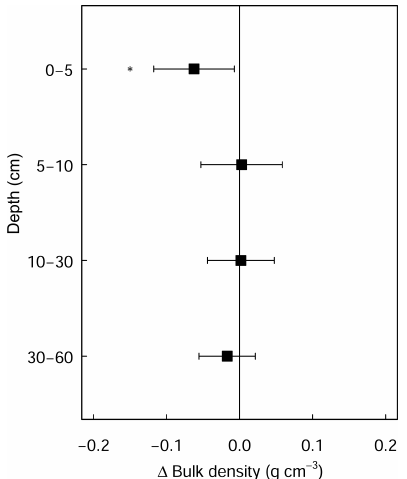
Figure A3. Effects of N deposition on (a) SOC stock, (b) C content, and (c) dry mass of the L/O f horizon in unlimed coniferous forests. There was no significant correlation evident with broadleaf forests sites.